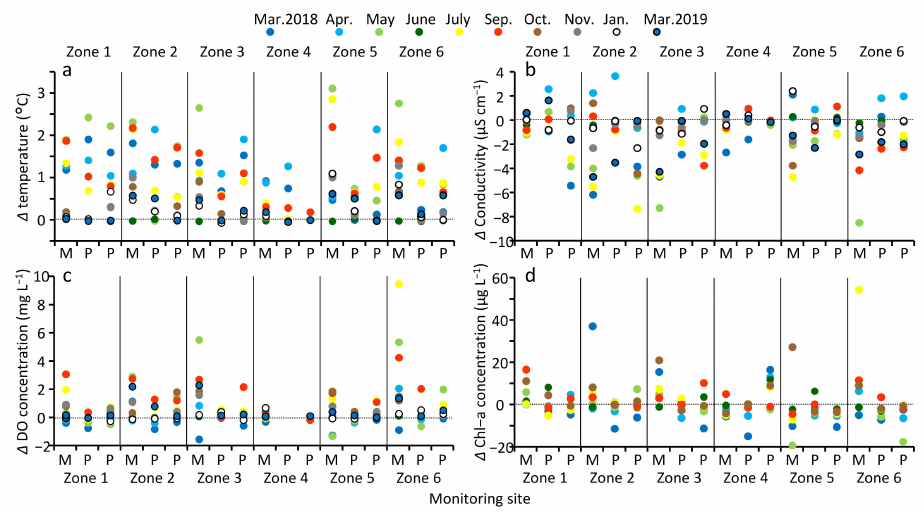
Figure 7. Surface-to-bottom vertical difference ( ∆ layer ) of temperature ( a ), EC ( b ), DO concentration ( c ), and Chl-a concentration ( d ) at 18 sites in MA. M: middle, P: periphery. Color shows month corresponding to that in other